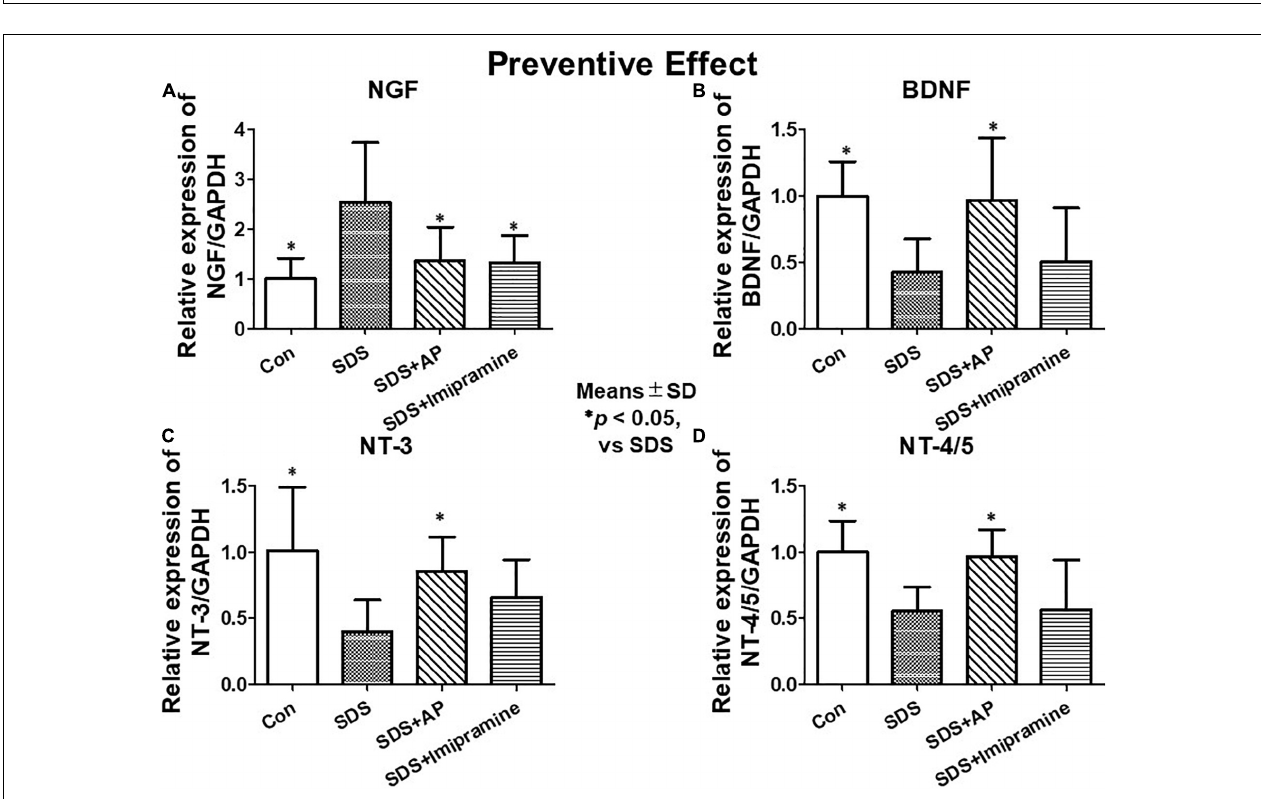
FIGURE 7 | mRNA expressions of neurotrophic factors in the brain of SDS mice with ongoing symptoms of depression quantified by real-time PCR. (A) NGF, (B) BDNF, (C) NT-3, (D) NT-4/5. Results are expressed as relative gene expression levels of mRNA. Values are means ± SD ( n = 8). ∗ p < 0.05 versus SDS group. AP, acupuncture; BDNF, brain-derived neurotrophic factor; GAPDH, glyceraldehyde 3-phosphate dehydrogenase; NGF, nerve growth factor; NT, neurotrophin; SD, standard deviation; SDS, social defeat stress.